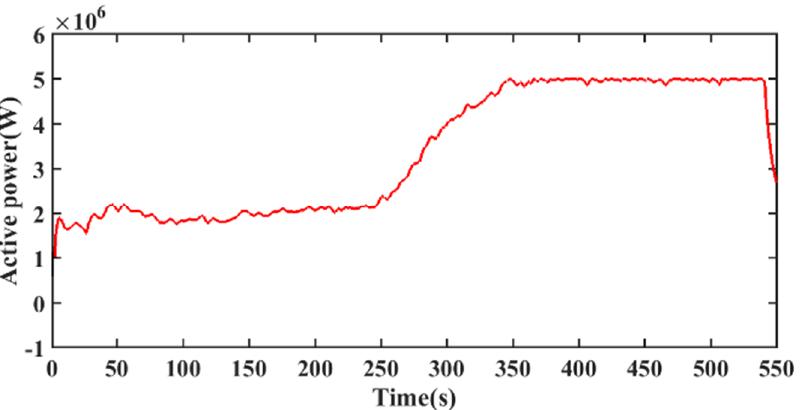
Figure 15. Active power output of WT4.